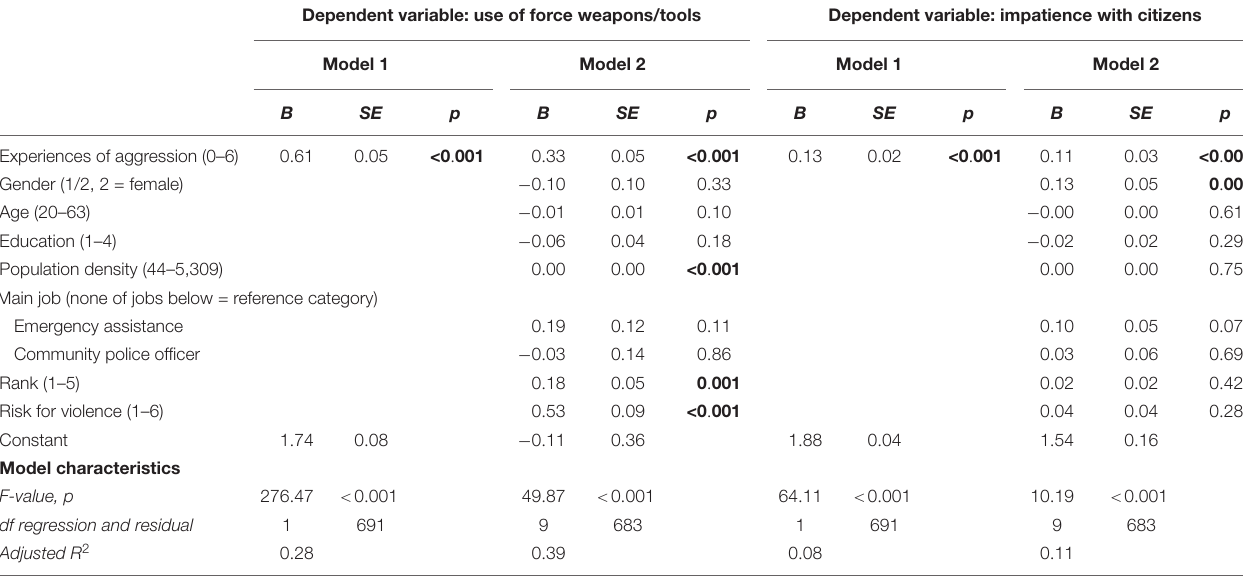
TABLE 3 | Regression models of the associations between experiences of aggression and behavior toward citizens, adding socio demographic and work characteristics T1, based on pooled results using multiple imputation ( N = 693) a . Dependent variable: use of force